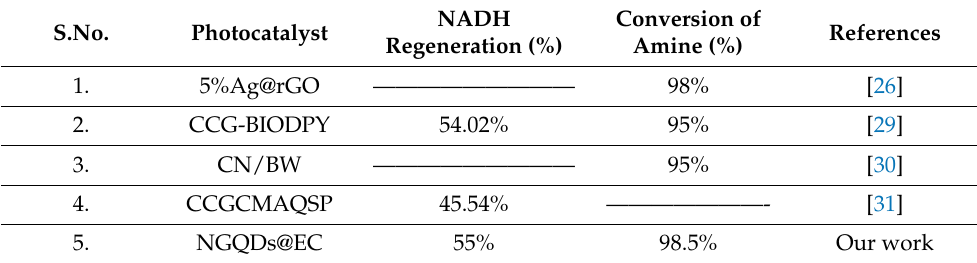
Table 2. Comparative study of different photocatalyst for light reaction.